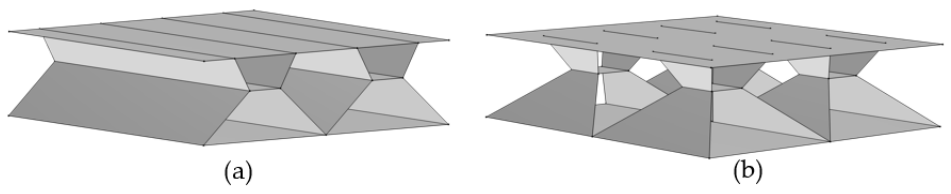
Figure 6. Three-dimensional ITPS configuration: ( a ) OTP1, ( b ) OTP2.